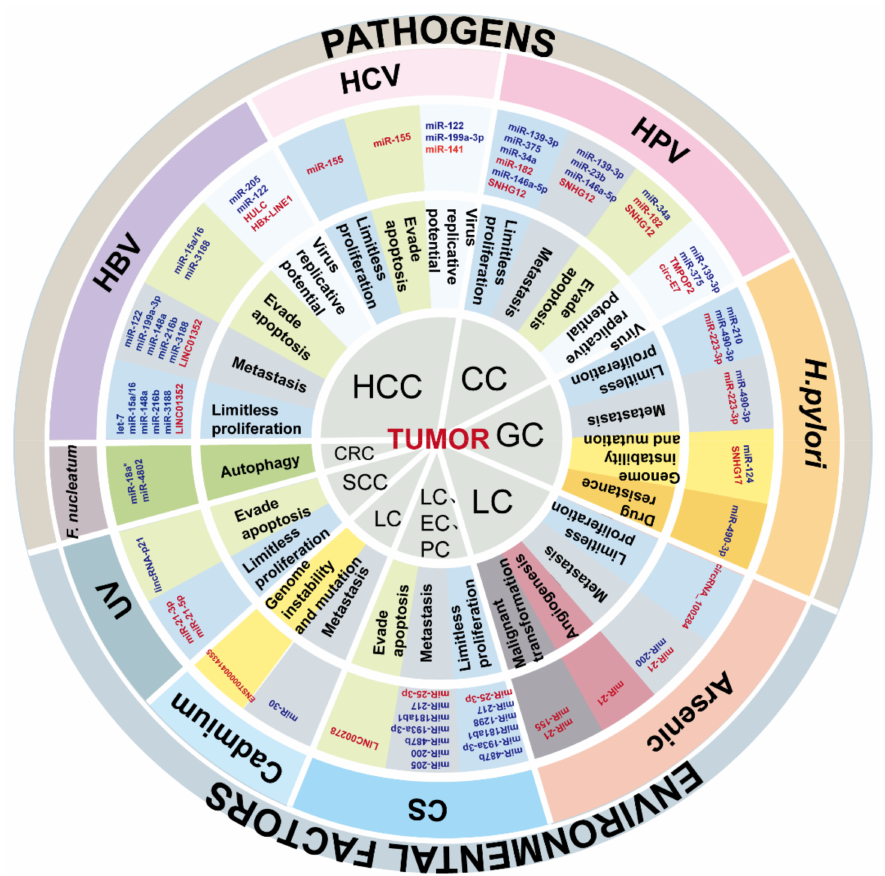
Figure 1. The schematic summation of ncRNA dysregulation and relevant cancer-promoting mecha- nisms. The ncRNAs up-regulated and down-regulated are depicted in red and blue,